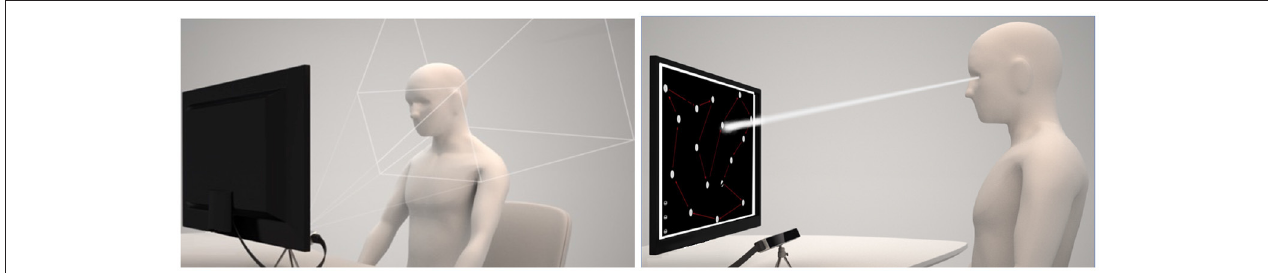
FIGURE 1 | Experimental Set-up: The picture on the left emphasizes the area in which the eye tracker can correctly acquire subject’s eyes. The picture on the right shows the eye tracker position and computed gaze direction of subject while performing the imagery task.